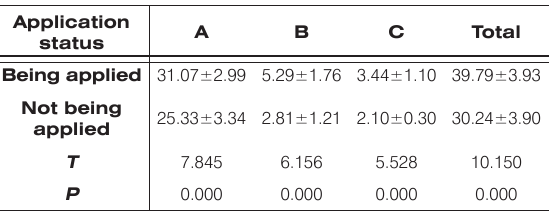
Table 2. Comparison of the evaluation scores of applied and unapplied clinical nursing studies Note: A: Level of the study; B: Value of the result; C: Effectiveness of the